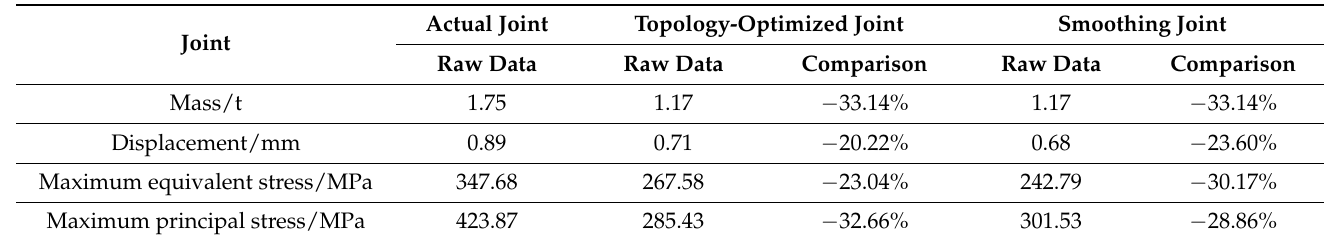
Table 1. Comparison of three types of